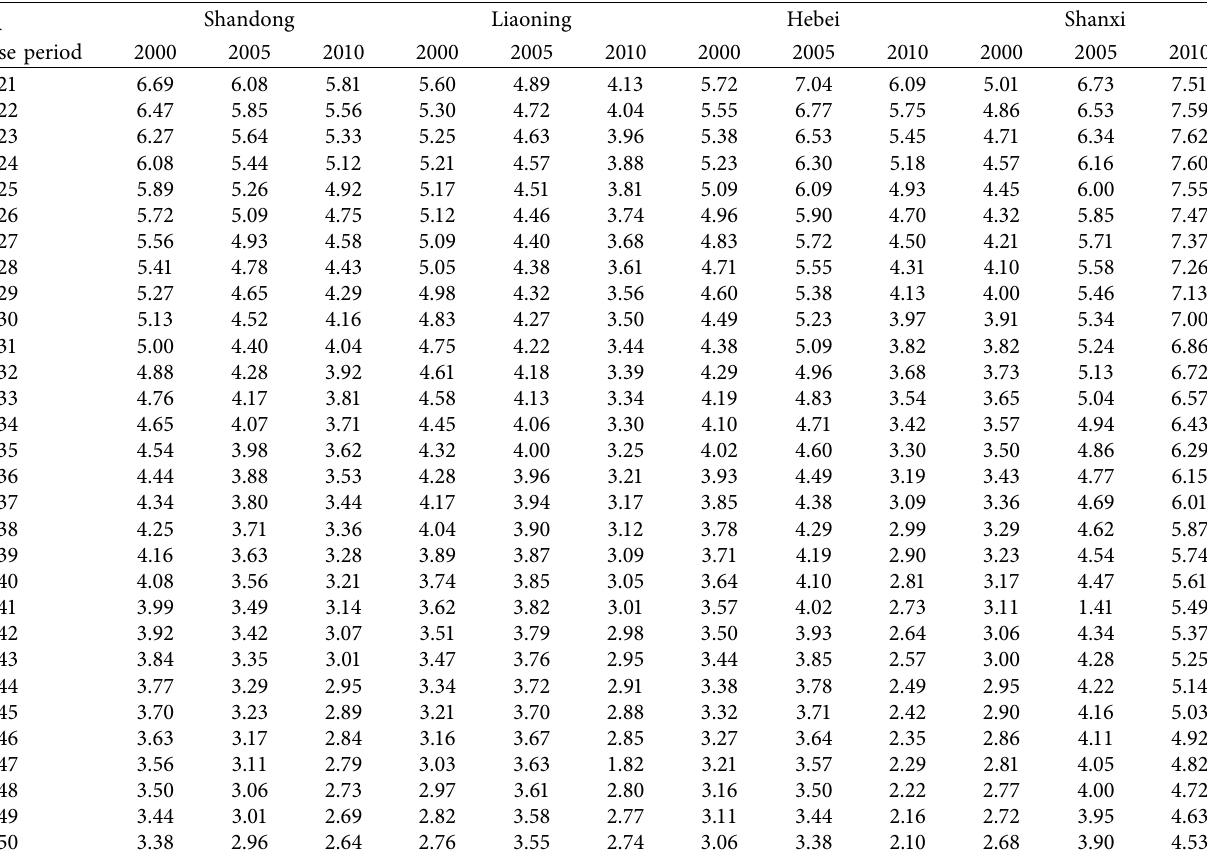
Table 1: Prediction of annual growth rate of GDP of Shandong, Liaoning, Hebei, and Shanxi from 2021 to 2050 (unit: %). PR Shandong Liaoning Hebei Shanxi